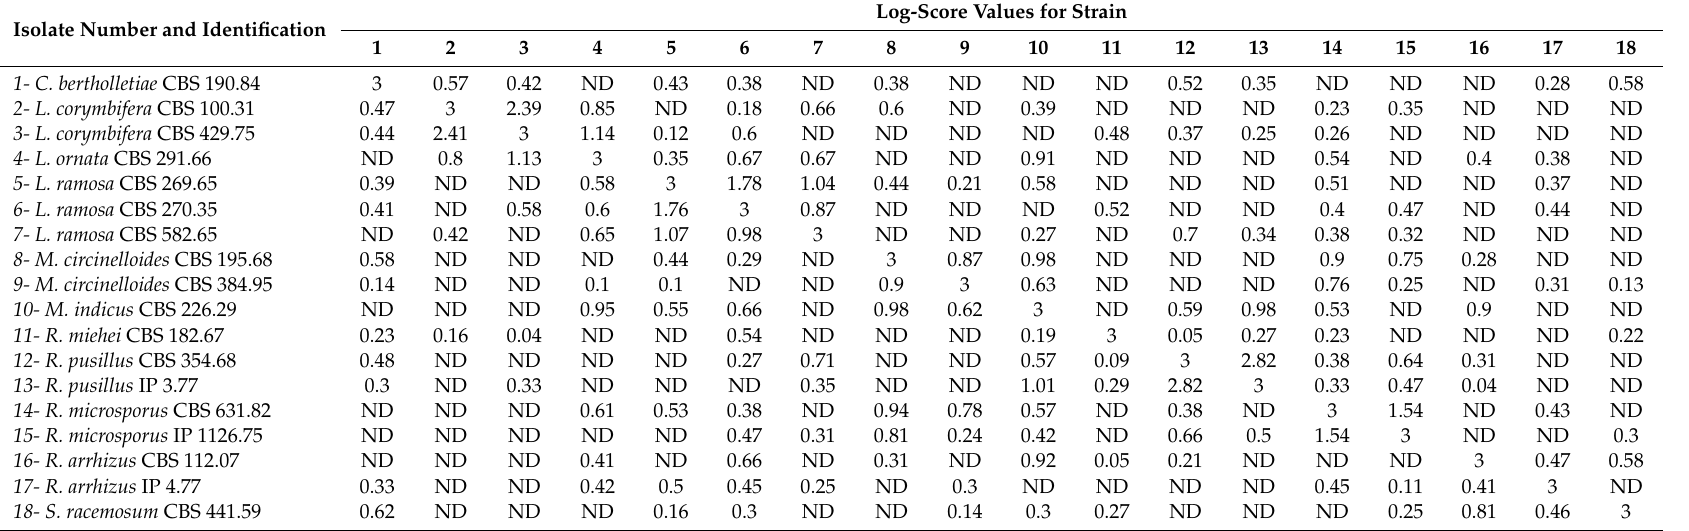
Table 3. Log-score values obtained when the main spectrum profiles were identified by the database itself. For each isolate, the log-score values for the first 10 best matches are